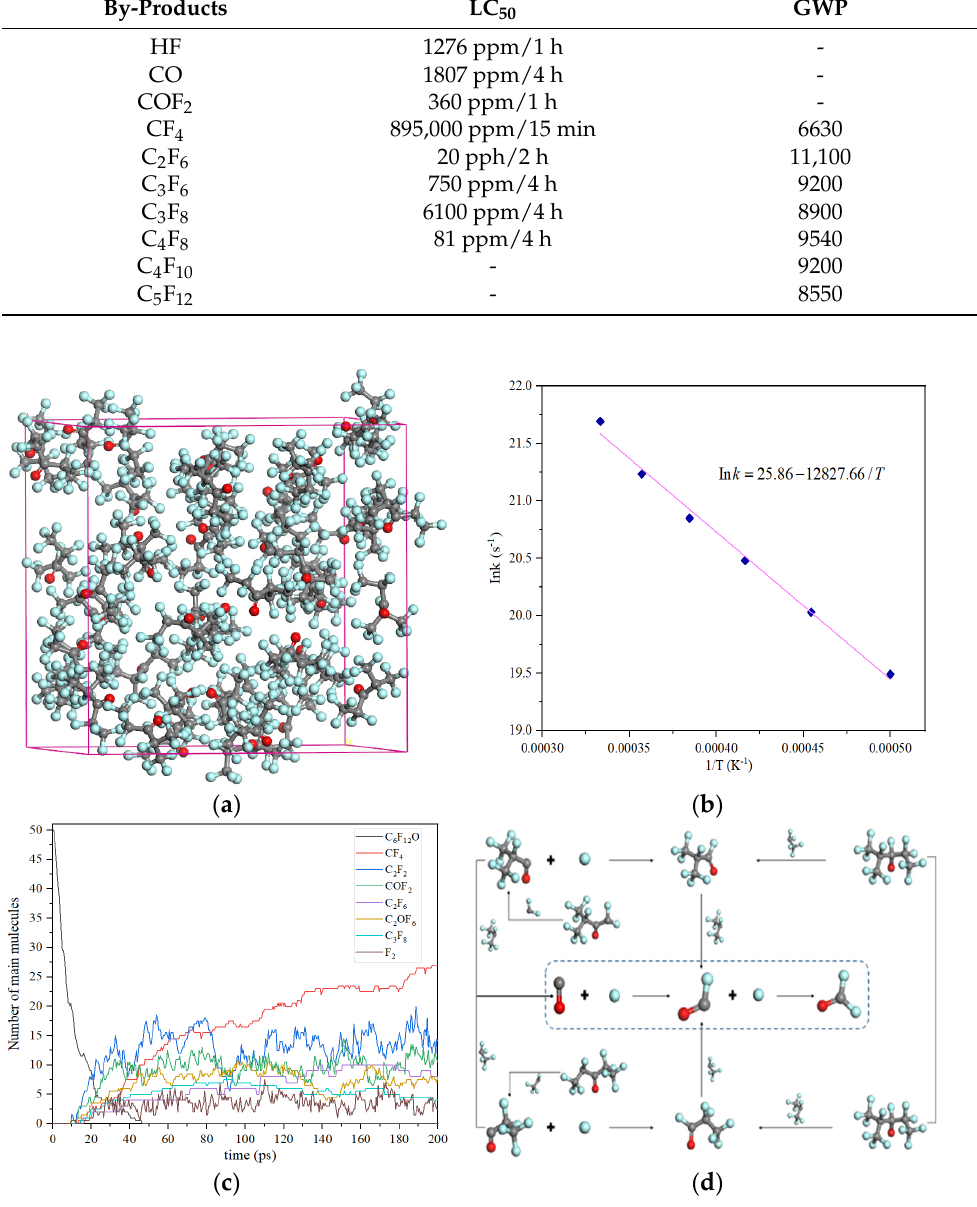
Figure 1. A reactive molecular dynamics study of the pyrolysis mechanism of C 6 F 12 O [21]: ( a ) simu- lation model, ( b ) Kinetic analysis of C 6 F 12 O pyrolysis, ( c ) evolution of the main pyrolysis